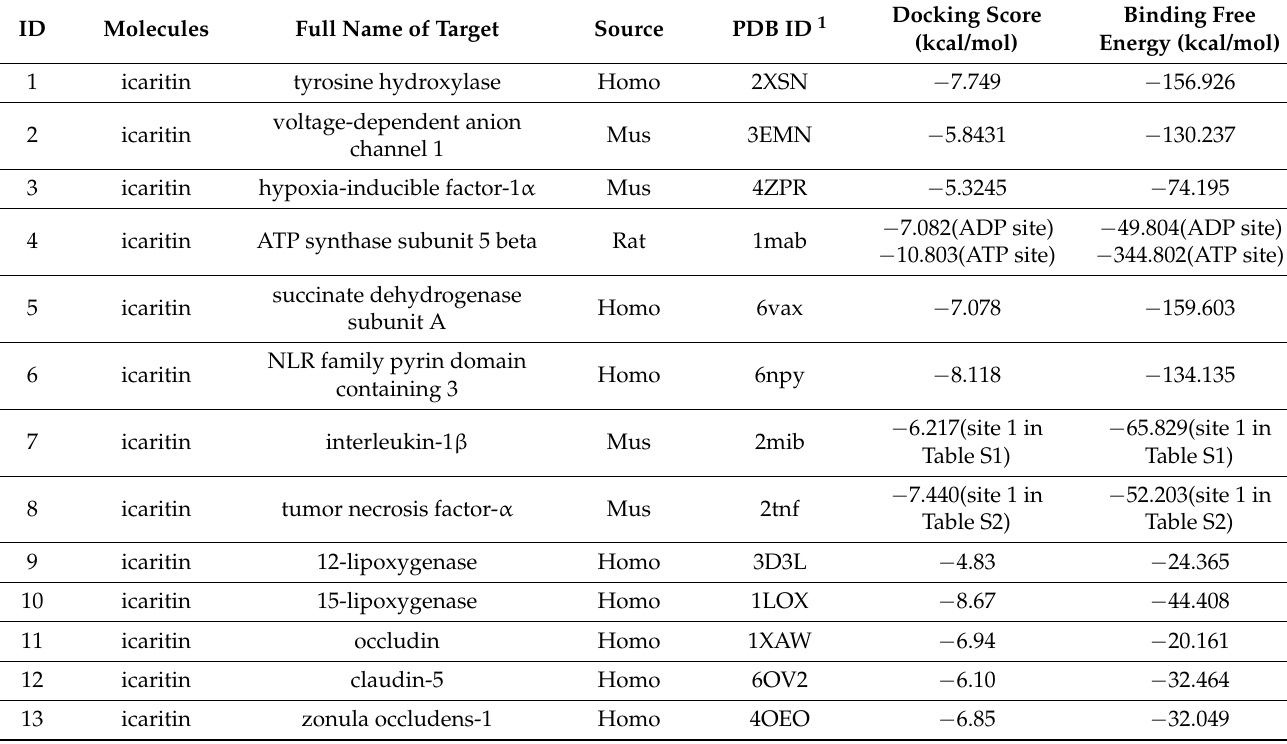
Table 1. The list of docking